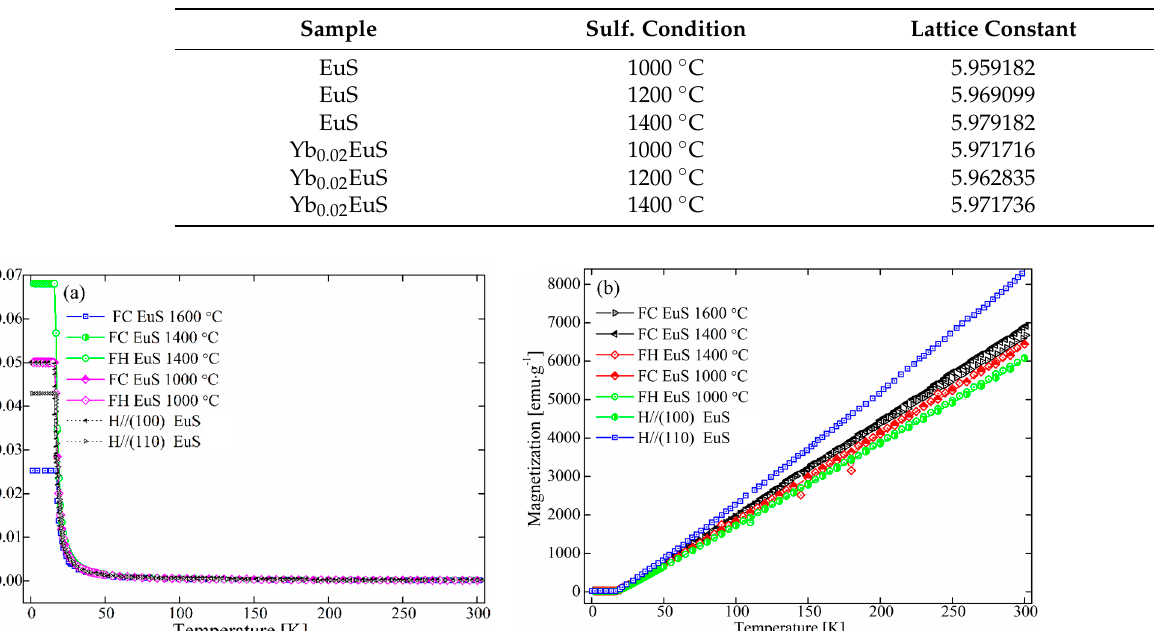
Figure 2. The relationship between FH and FC magnetization of the prepared EuS and tempera- ture: ( a ) the temperature dependence of magnetization M(T); ( b ) the inverse susceptibility curve, 1/ χ , for sintered polycrystalline EuS; the magnetic data of single-crystal EuS along (100) and (110) directions [13] were added to compare the difference between single-crystal and polycrystalline EuS magnetic data .